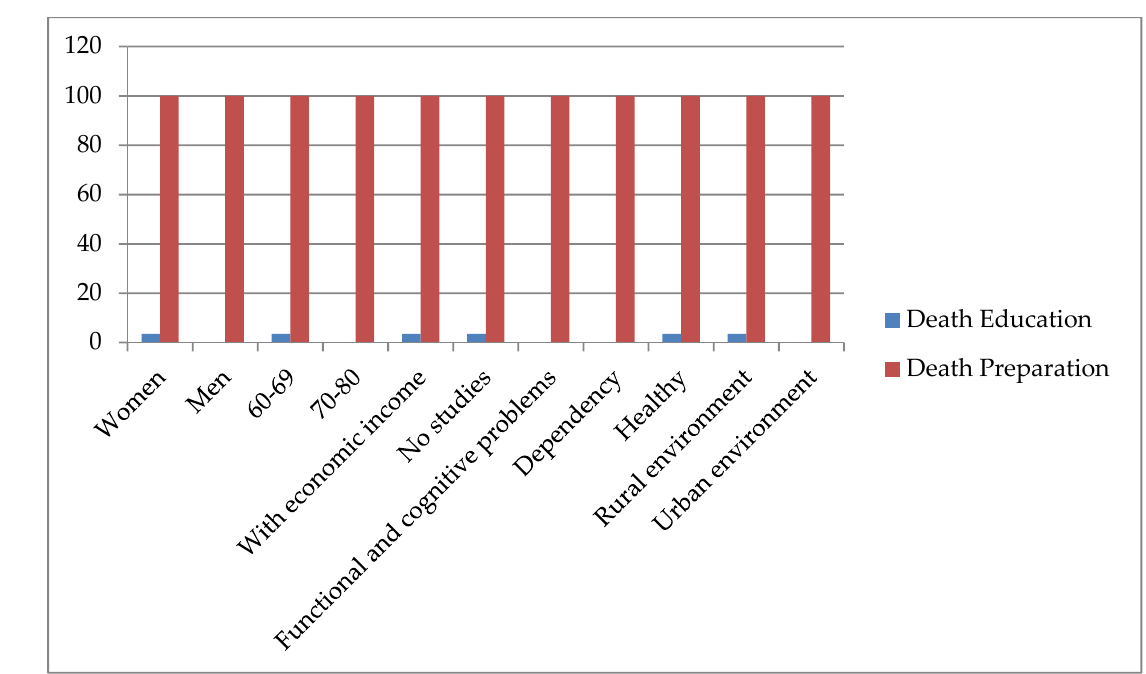
Figure 1. Death and preparation for death.